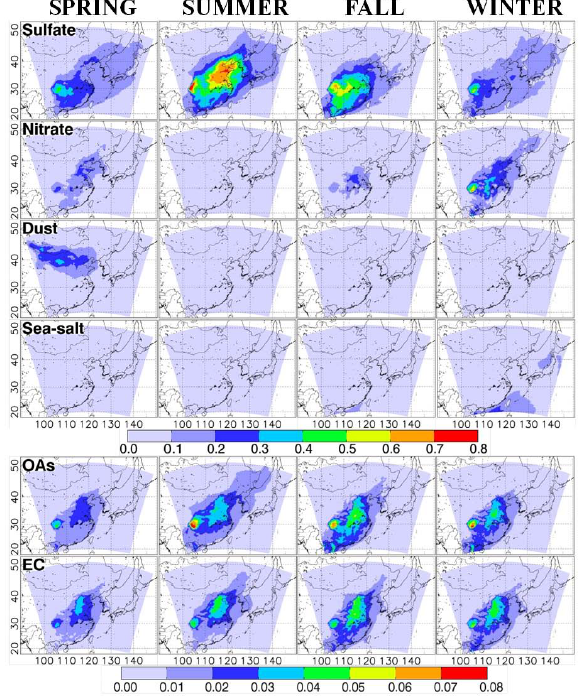
Fig. 8. Spatial distributions of the particulate species-wise AOD (i.e. R σ ext , species dz) for all four seasons, 2006.